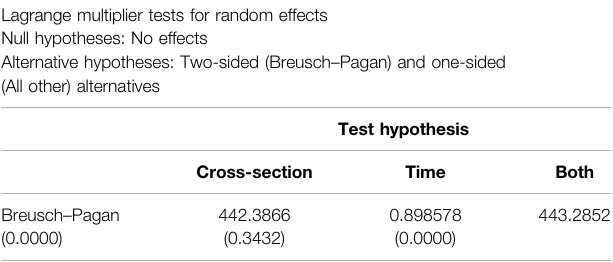
Figure 8 is the graphical representation of Eq. 2 .